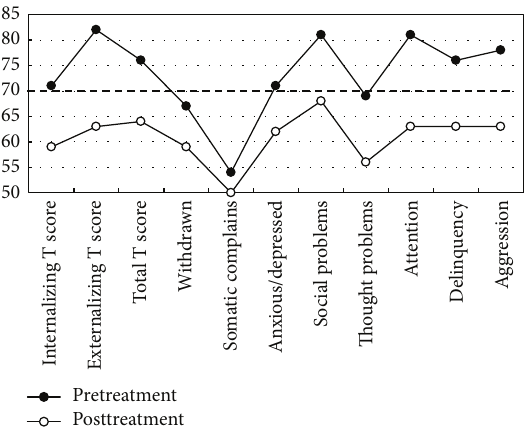
Figure 2: Child Behavior Checklist scores of general scores and subscores before and after